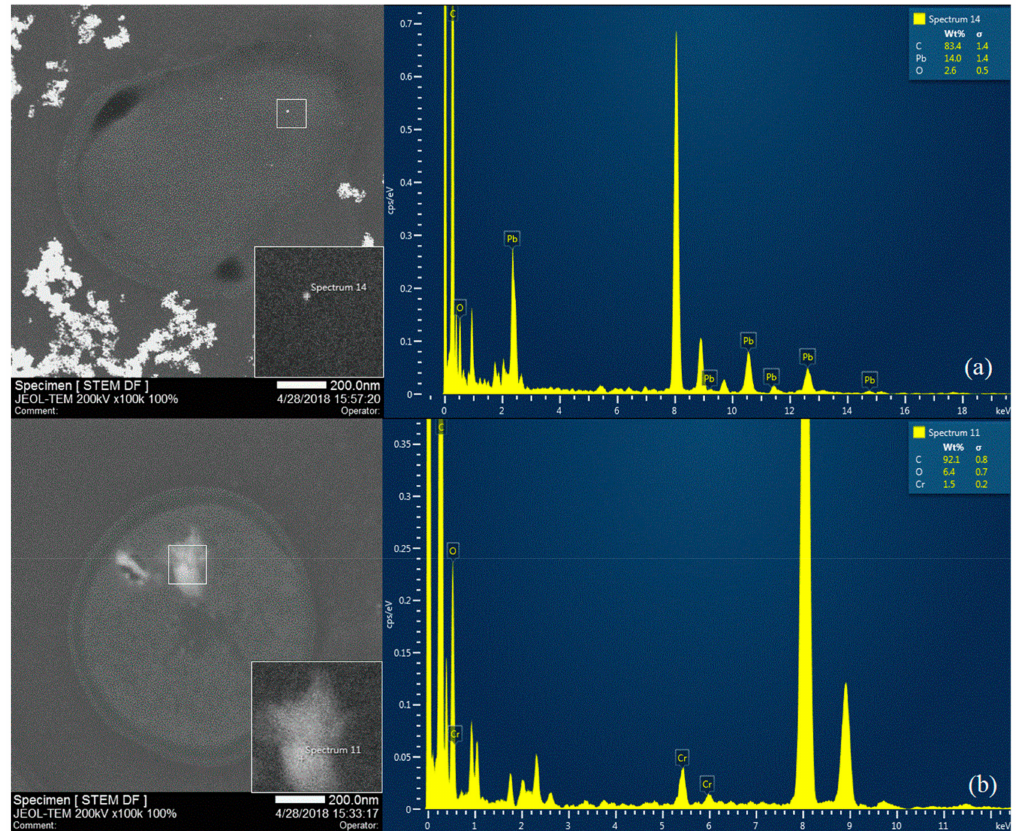
Figure 4. STEM-EDS of intracellular bioaccumulation images under 1 mmol · L − 1 Pb ( a ) and Cr ( b )